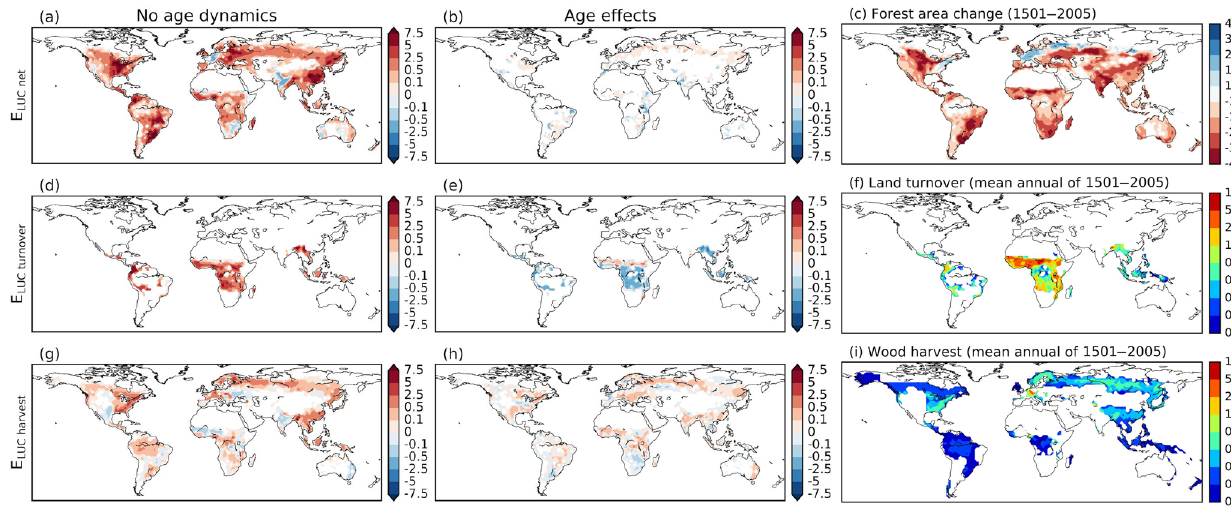
Figure 3. (a–c) Spatial distribution of E LUC net for 1501–2005 (kgCm − 2 ) as simulated by S ageless simulations, the age effect quantified as difference in E LUC net between S age and S ageless , and the cumulative forest loss as a result of net land use change as a percentage of grid cell area. (d–f) Similar to (a–c) but for E LUC turnover , with (f) showing the mean annual grid cell percentage impacted by land turnover over 1501–2005. (g–i) Similar to (a–c) but for E LUC harvest , with (i) showing the mean annual grid cell percentage impacted by wood harvest (i.e. sum of wood harvest on primary and secondary forests) over 1501–2005.